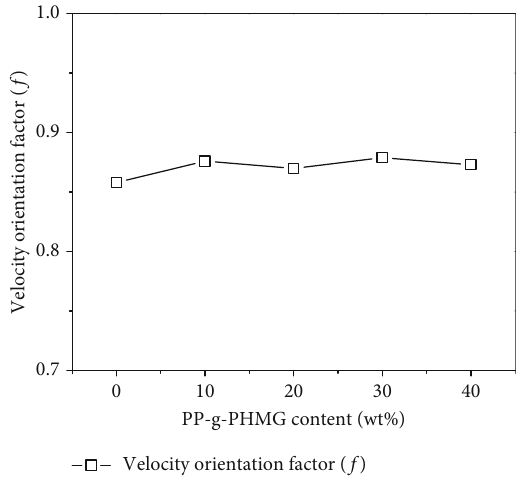
Figure 3: Velocity orientation factor of PP-g-PHMG/PE mono fi laments with di ff erent PP-g-PHMG